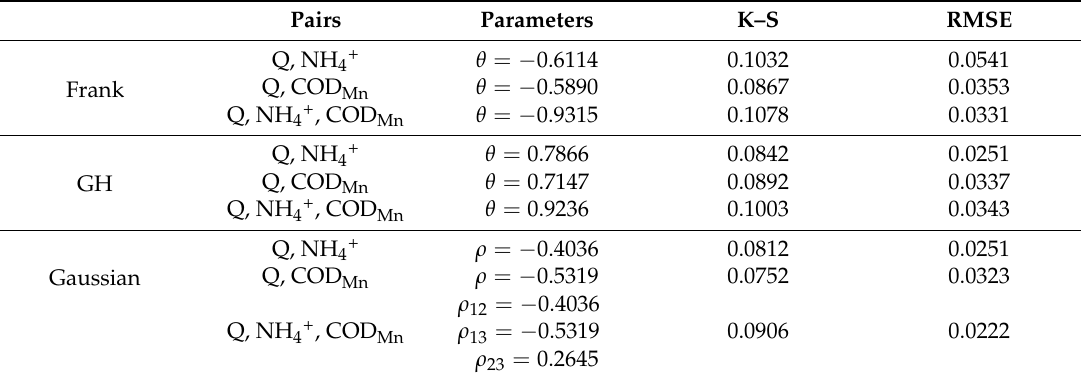
Table 4. The parameters of copulas of Q, NH 4+ , and COD Mn , and results of K–S and RMSE. Pairs